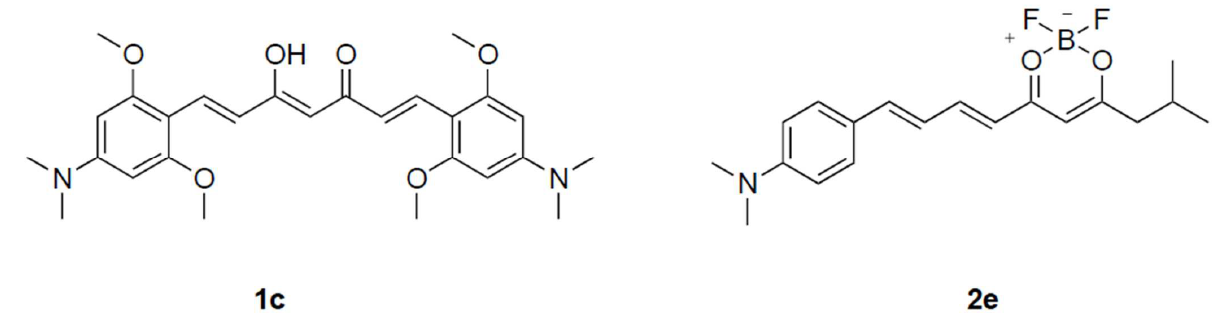
Figure 7. The chemical structures of probes (1c and 2e) which can detect Tau